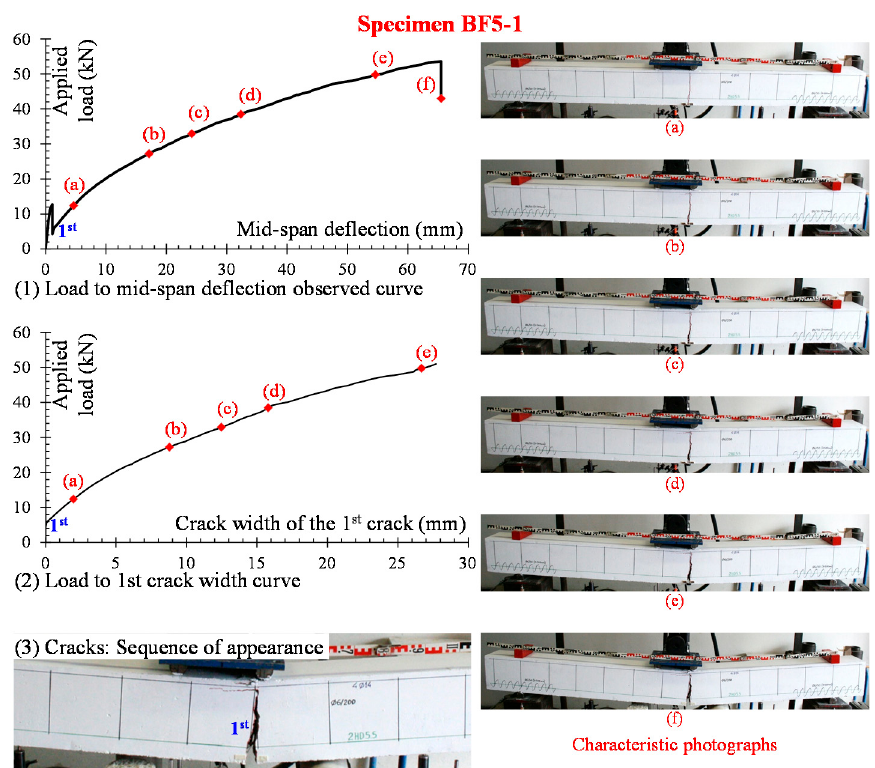
Figure 5. Beam BF5-1. Load to midspan deflection (1) and load to crack width (2) observed curves. Photographs at characteristic points ( a ) to ( f ). Sequence of appearance of the observed cracks (3).